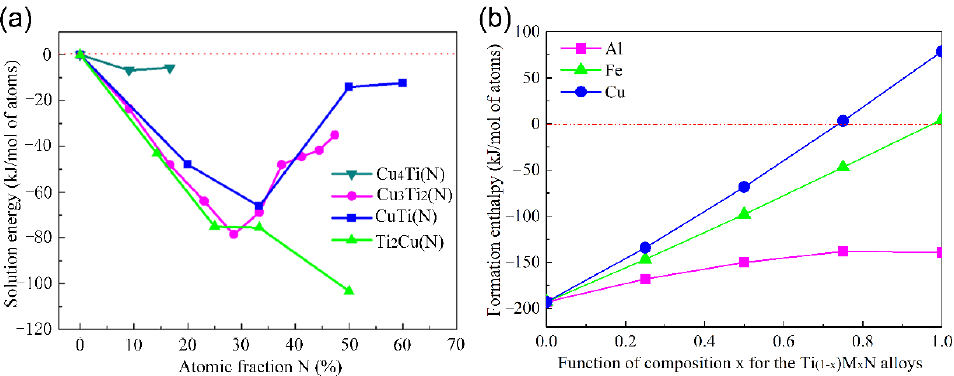
Figure 12. ( a ) The change in the solution energy for N in Cu-Ti intermetallics; ( b ) the formation enthalpy of Ti (1 − x) M x N.